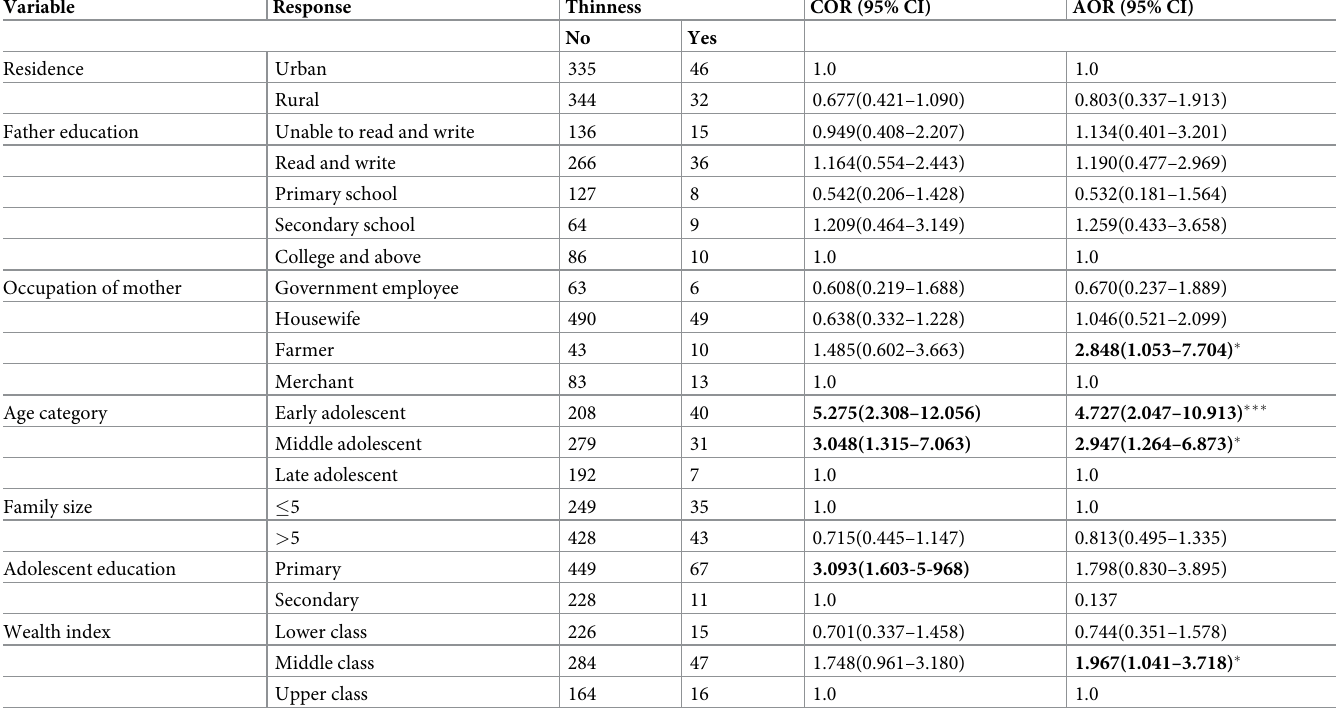
Table 8. Bivariable and multivariable logistic regressions of overall factors associated with overall thinness among school adolescent girls in Debark district, 2020 (n = 757).